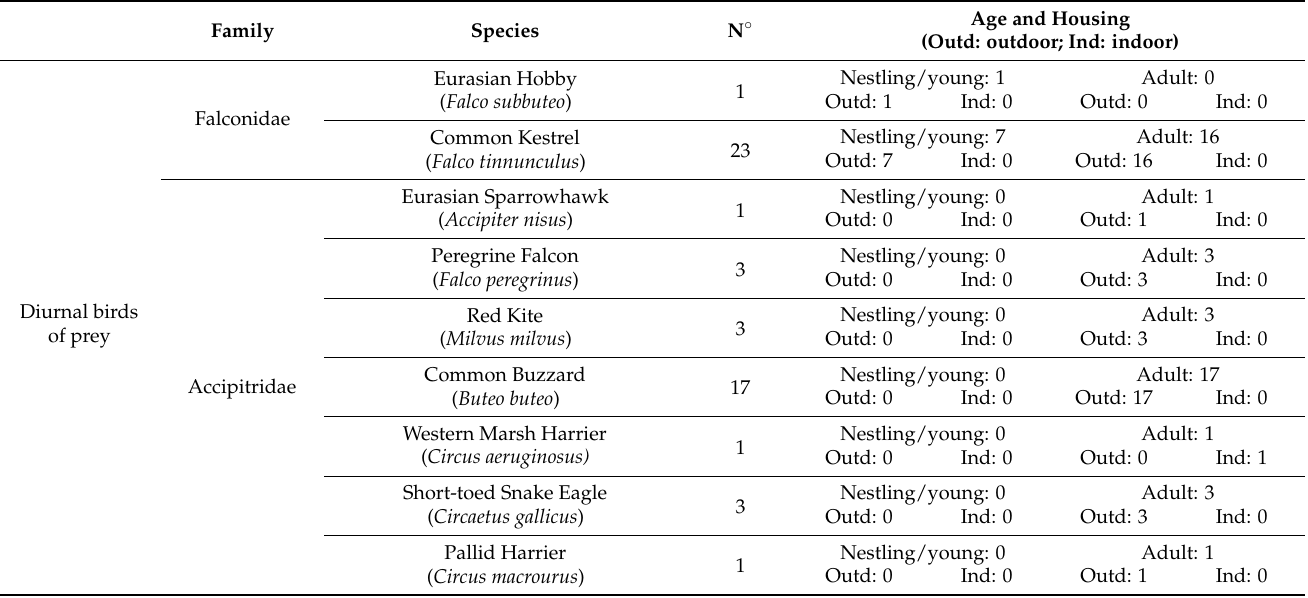
Table 1. Species and number of specimens tested in the